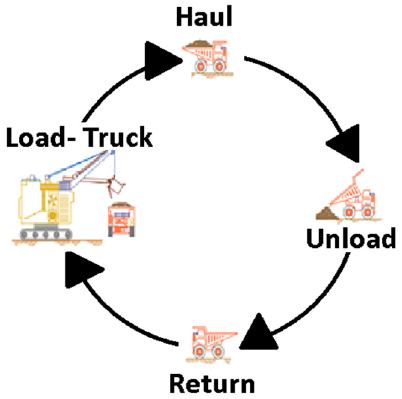
Figure 1. Cycle of the Shovel-Truck system.